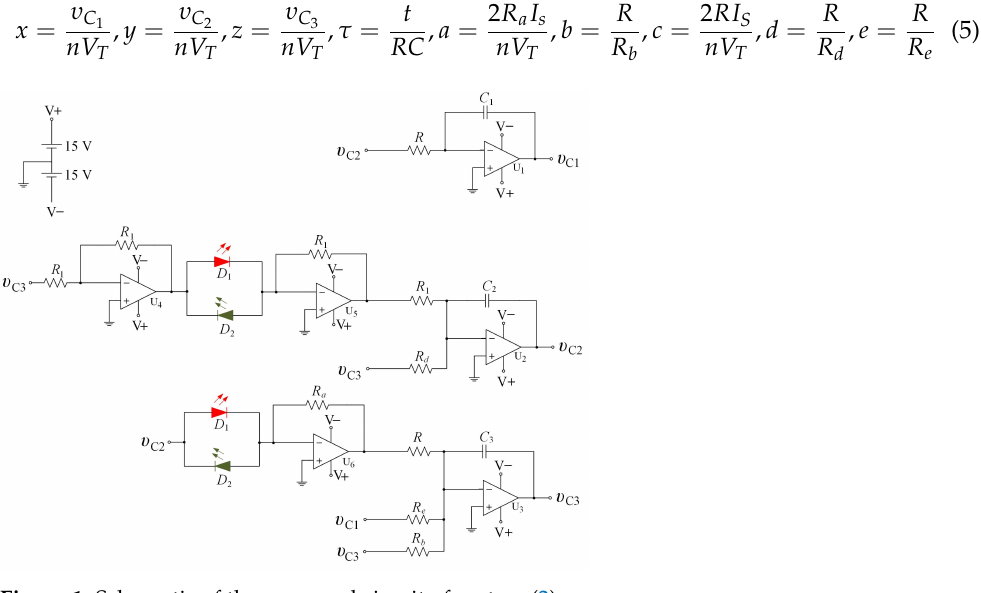
Figure 1. Schematic of the proposed circuit of system